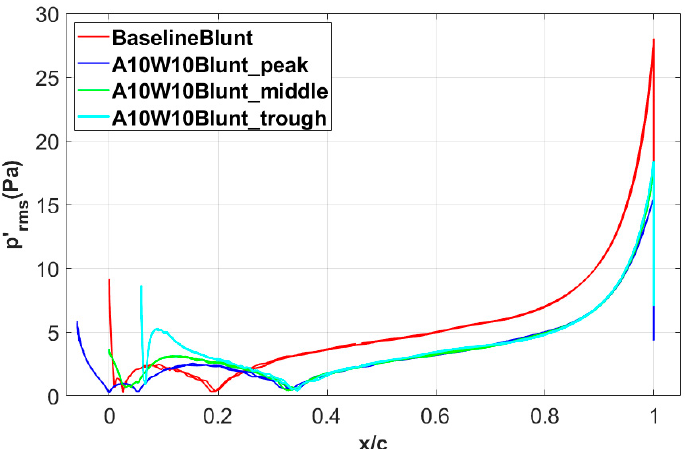
Figure 13. Distribution of the pressure fluctuations at different spanwise positions on the airfoil’s surface.